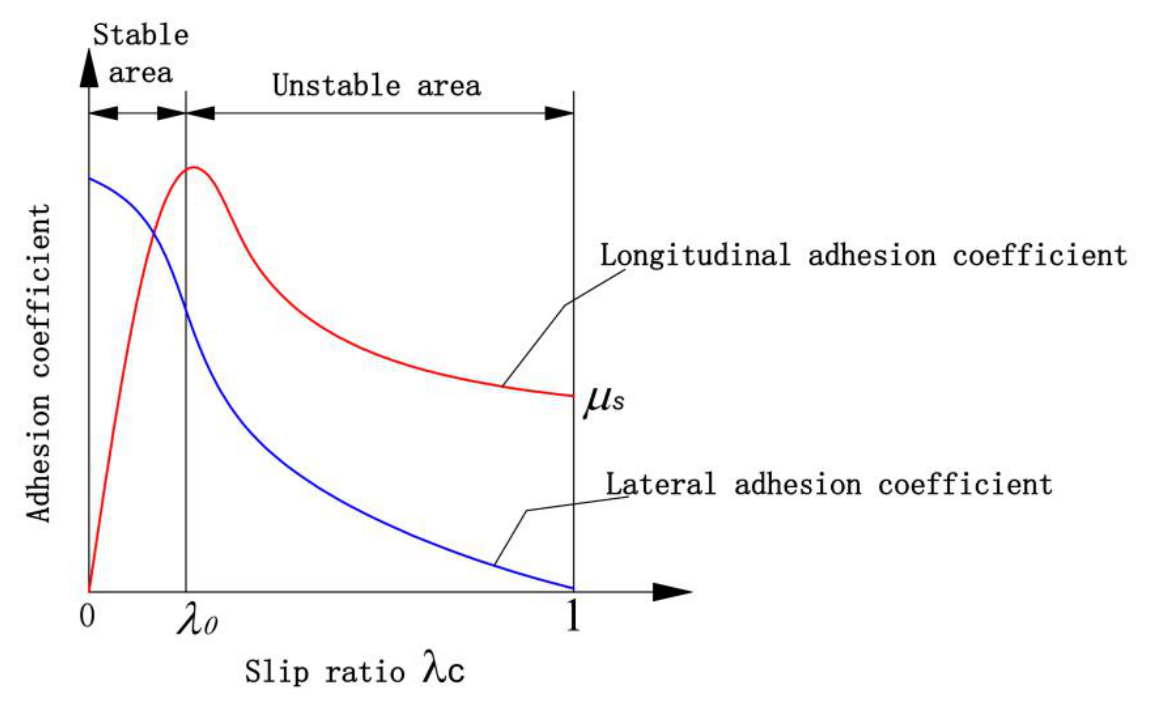
Figure 13. The relationship between the brake road adhesion coefficient and the slip ratio.